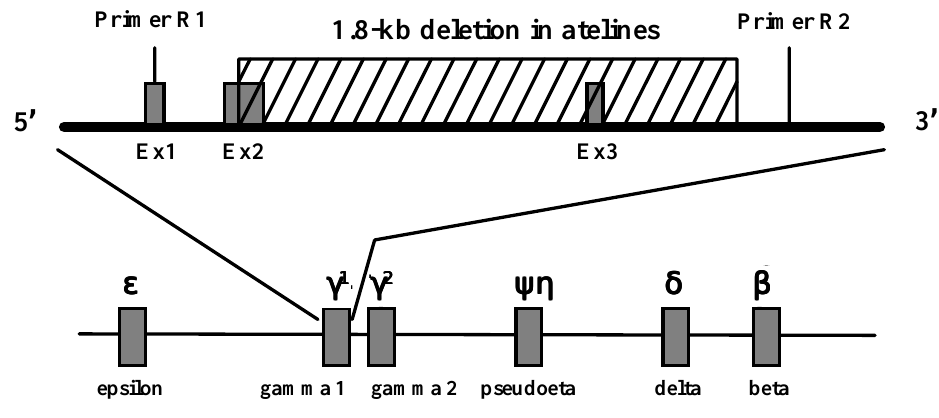
Figure 1 - Model of the b -cluster showing the five globin genes. The g 1 -globin pseudogene is amplified exhibiting the primers R1 and R2 used in this study and also the 1.8-kb deletion shared by all four Alouatta species as well as by the ateline group (Meireles et al ., 1995,